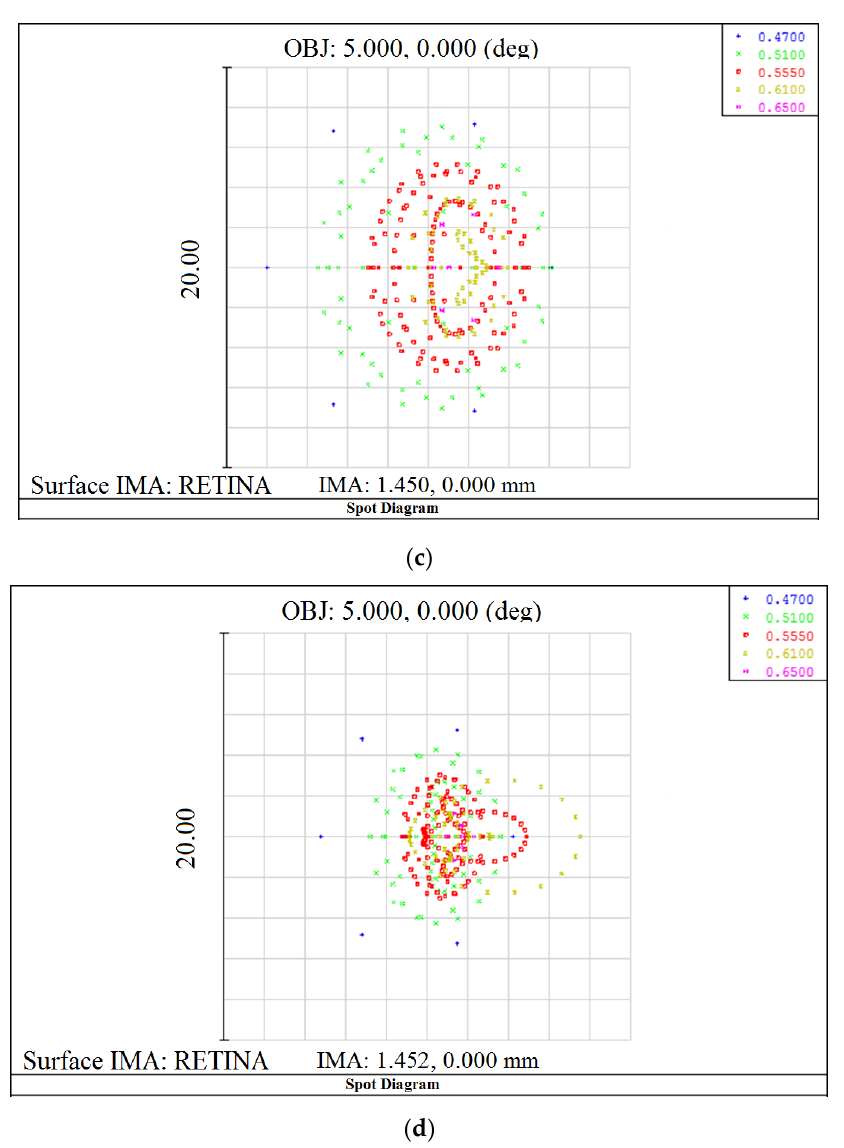
Figure 6. Comparison of the formed retinal image ( a ) without CL, ( b ) with PMMA CL, ( c ) with 0.005 PMMA-TiO 2 CL, and ( d ) with 0.01 PMMA-TiO 2 CL.